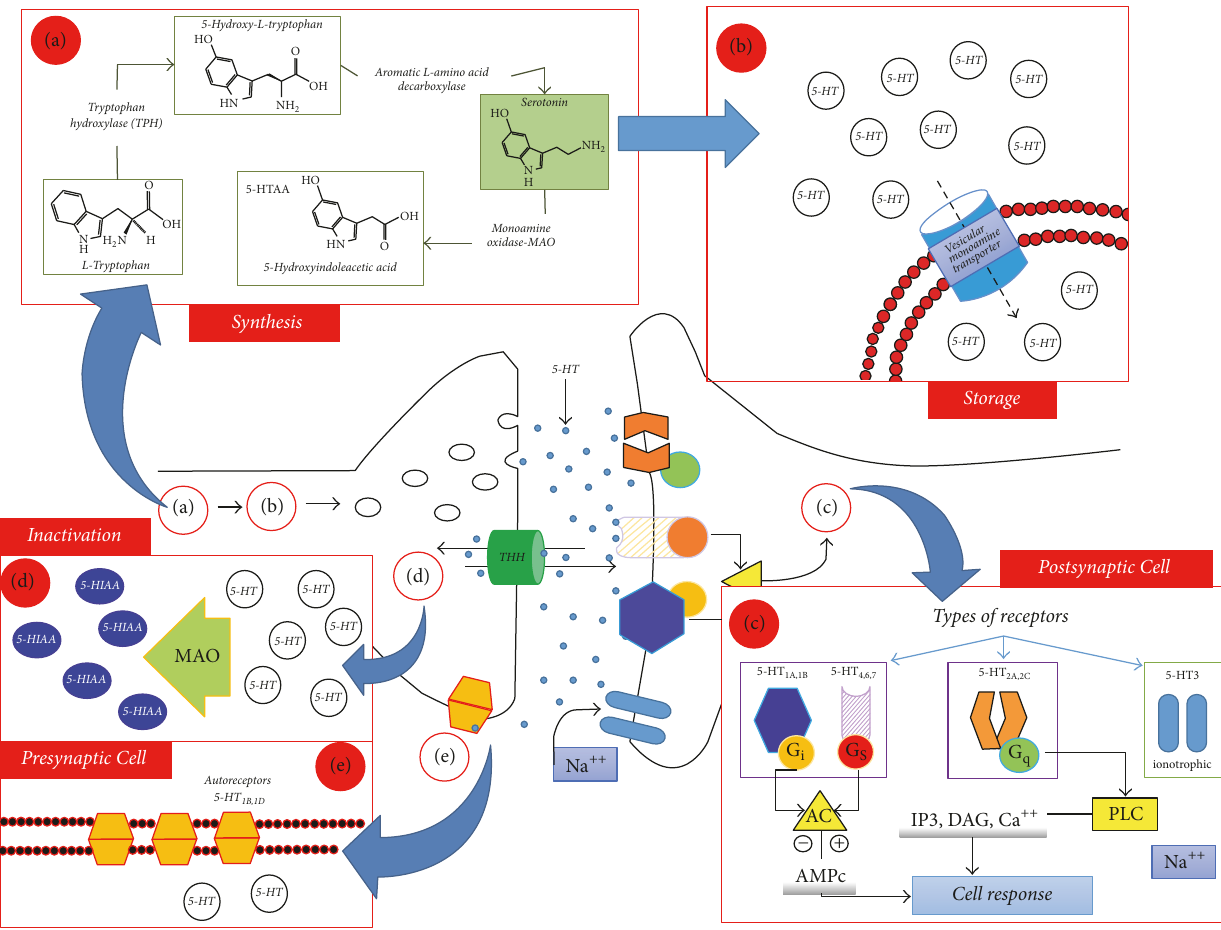
Figure 1: Representation of serotonergic synapses (synthesis, storage, liberation, and recapture). Processes related to serotonergic synapses. (a) Synthesis and metabolism: tryptophan is taken by the neuron through active transport mechanisms; (b) storage: once synthesized, it is stored in synaptic vesicles by vesicular transporters of monoamines (Vmat). When it is liberated, the serotonin interacts with various types of receptors; (c) postsynaptic receptors: the vast majority of postsynaptic receptors are G-protein coupled metabotropic receptors (HTR1A and HTR1B coupled to protein Gi and receptors HTR4, HTR6, and HTR7 are coupled to protein Gs) that activate adenylyl cyclase (AC), which in turn activates cyclic AMP, generating a cellular response; HTR2A and HTR2C are coupled to protein Gq and when activated, activate phospholipase C that triggers activity in inositol trisphosphate (IP 3 ), diglyceride (DAG), and an increase in levels of intracellular calcium (Ca ++ ), leading to a cellular response. The HTR3 receptors are postsynaptic and ionotropic, activated by ligands, allowing the flow of sodium (Na + ) ions; (d) inactivation: once recaptured, the serotonin is inactivated by monoamine oxidase (MAO) enzymes, generating 5- hydroxyindoleacetic acid (5-HIAA); (e) presynaptic stimulation: HTR1B and HTR1D receptors modulate the liberation of serotonin. Adapted from